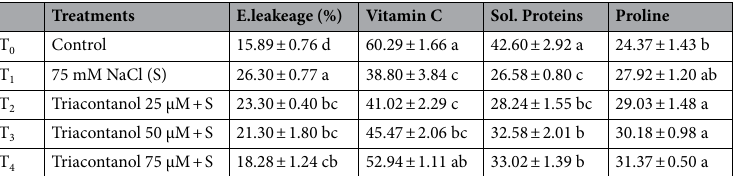
Table 5. Effects of triacontanol spray on electrolyte leakage and biochemical attributes of Hot pepper plants under salt stress. Means sharing the same letter for a parameter, do not differ significantly at p ≤ 0.05; Sol. Protein = soluble